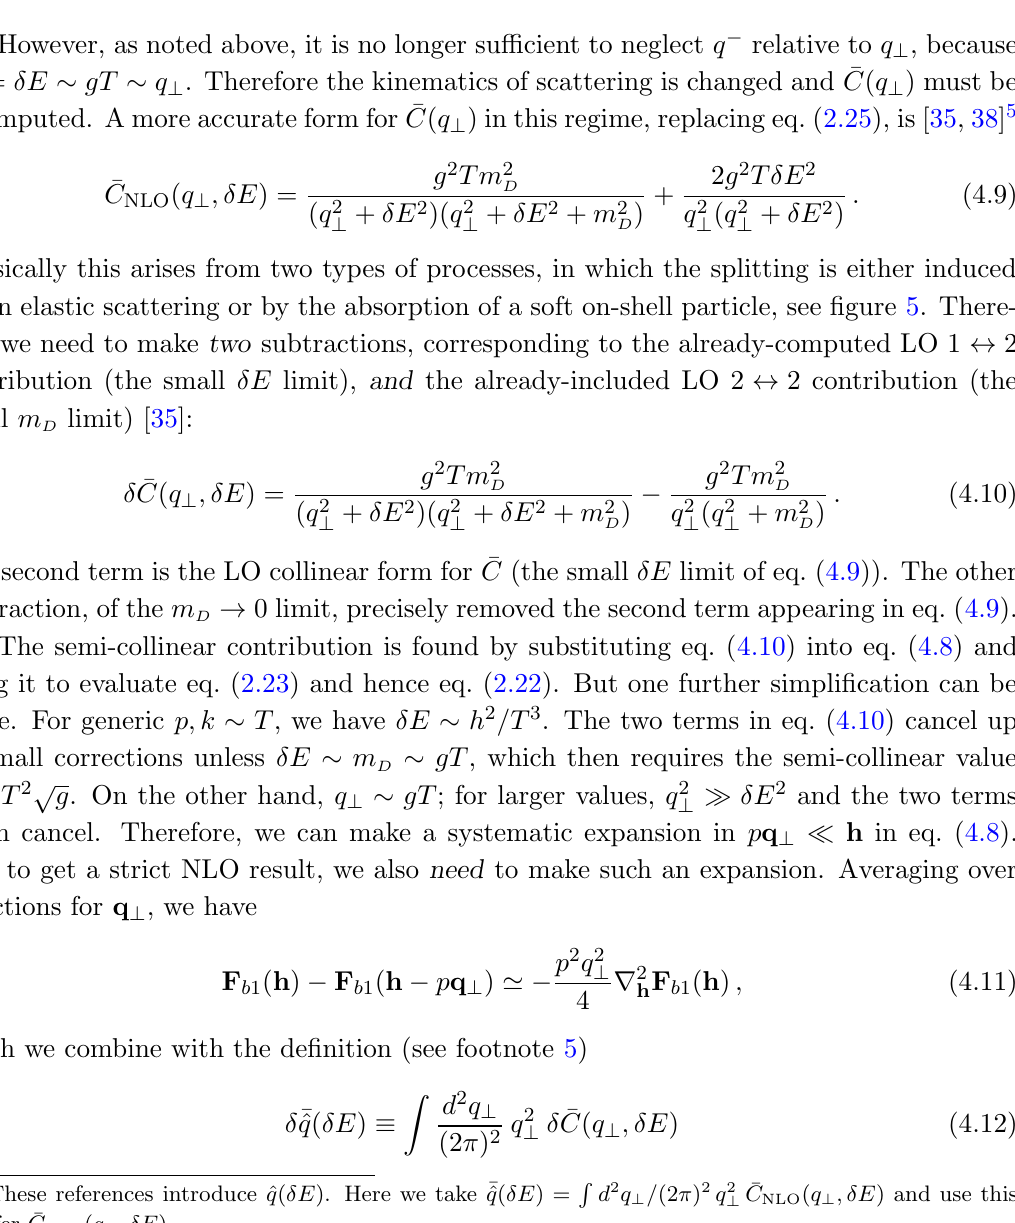
Figure 5 . Diagrams for typical semi-collinear processes. The exchange of momentum h =p and energy with the plasma can be due to elastic scattering or absorption of a soft quasiparticle, leading to the semi-collinear splitting